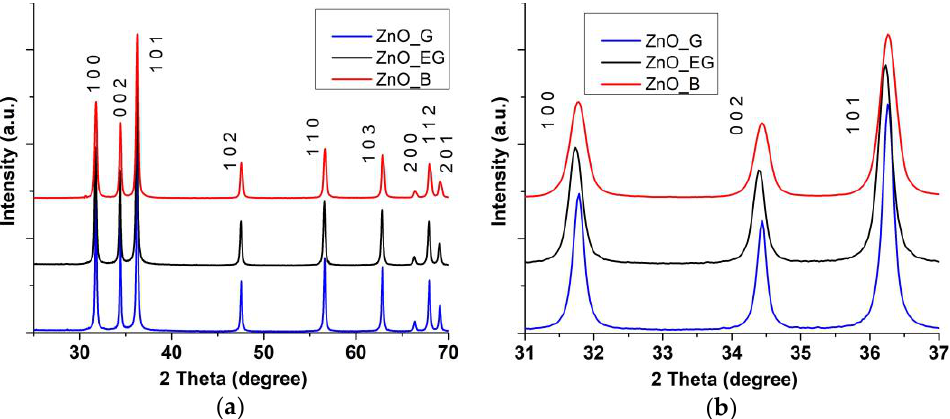
Figure 2. The X-ray diffractograms for: ( a ) ZnO_B, ZnO_EG and ZnO_G samples; ( b ) detail for the 2θ = 31–37° interval.